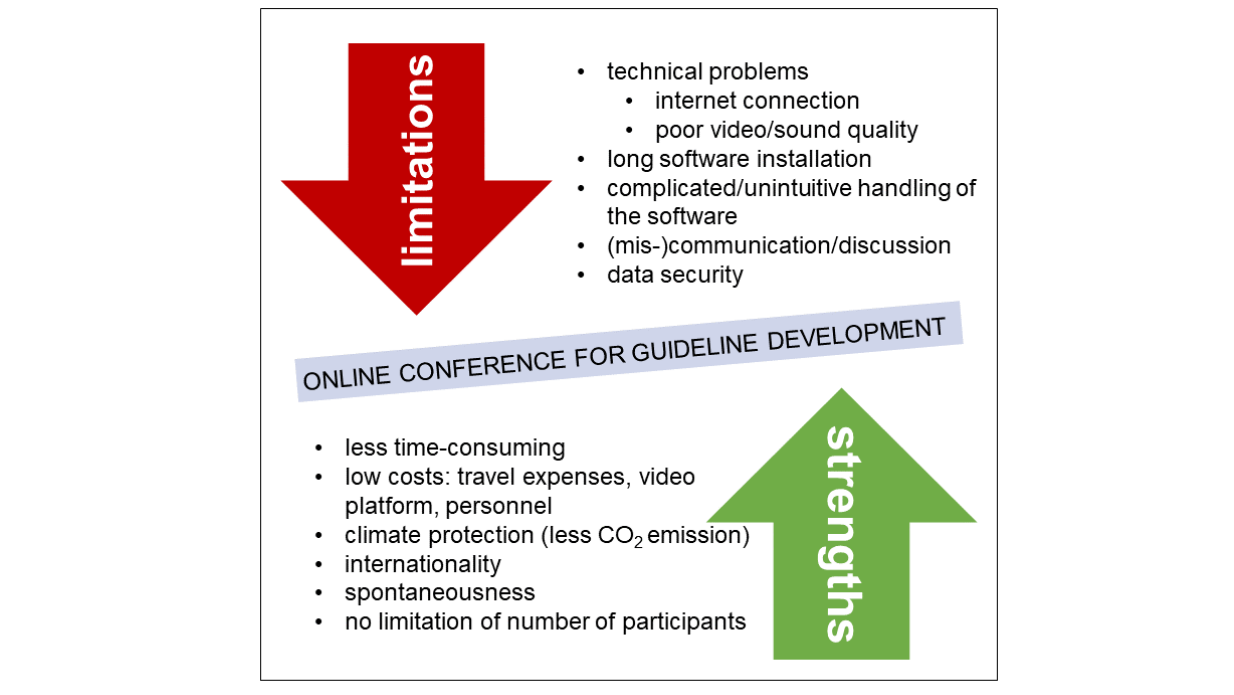
Figure 1. Strengths and limitations of online conferences for medical guideline